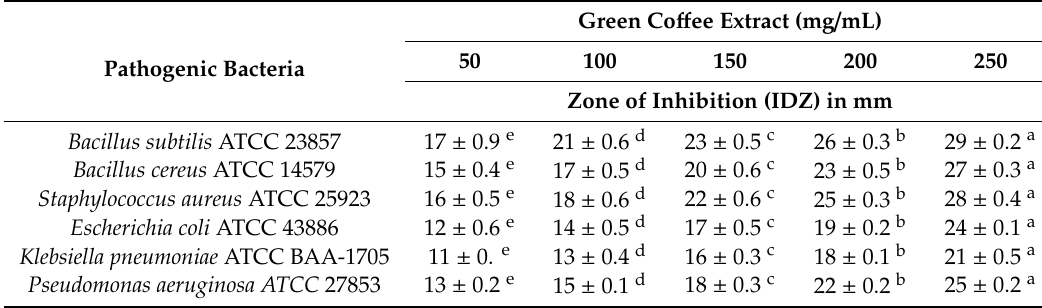
Table 8. Zone of inhibition produced by the green co ff ee